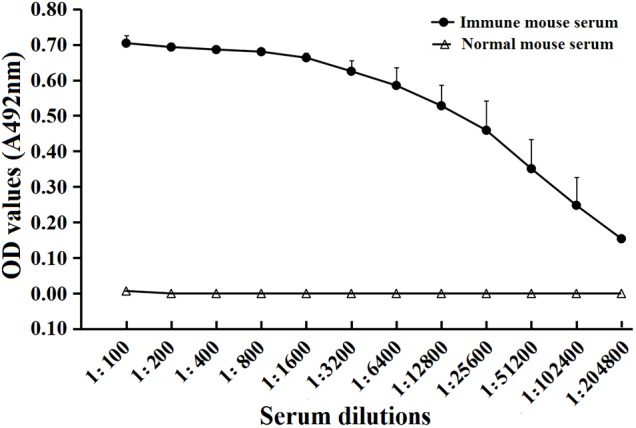
Serum anti-rTsSPI IgG titers after the fourth immunization in immunized mice determined by ELISA. The data are presented as the mean OD values ± SD of the antibody levels from twenty mice.